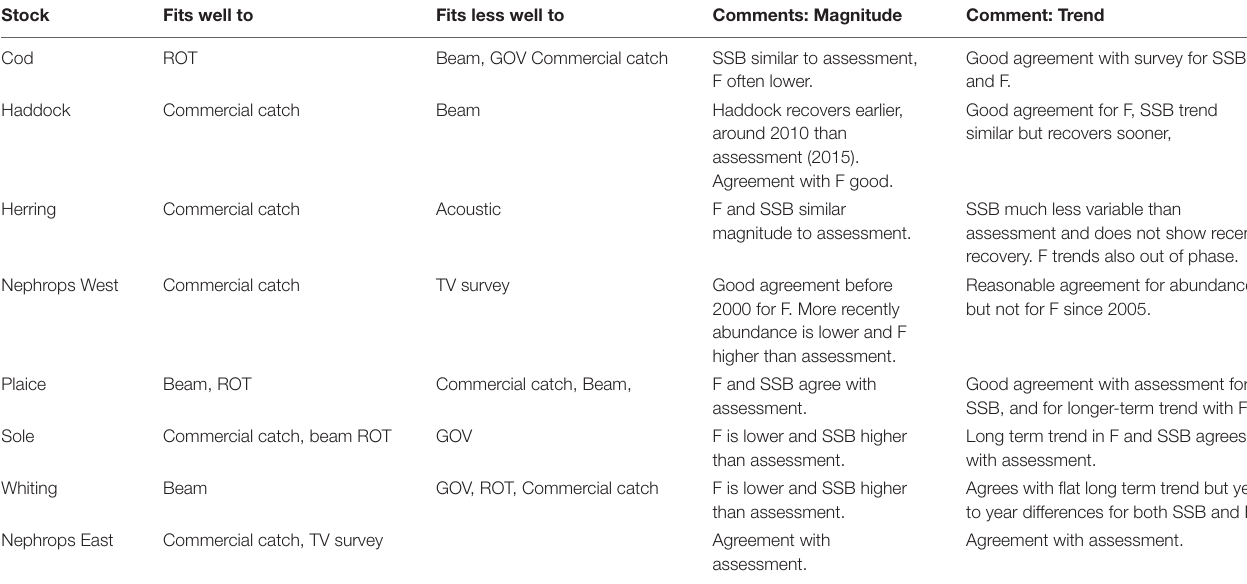
TABLE 4 | Summary of fits to catch and survey data and estimates of F and SSB for all eight